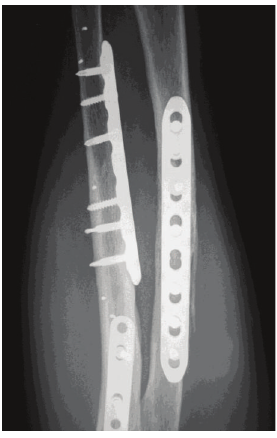
Figure 7: X-ray follow-up at 12 months after second surgery; there is no evidence of recurrence of bone formation.